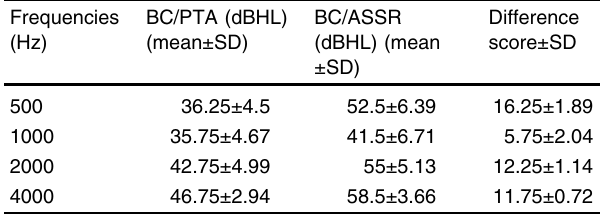
Table 2 BC/PTA and BC/ASSR thresholds and the difference score in normal children ( n = 35 ears)